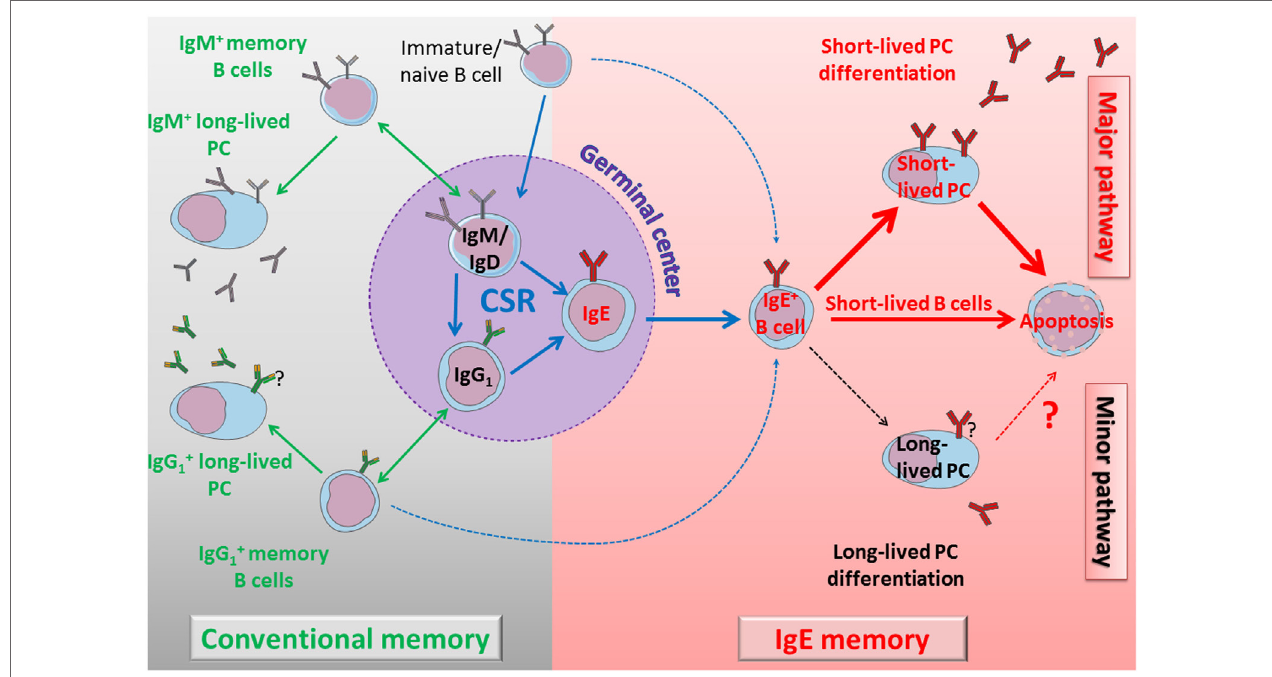
FigURe 4 | Self-controlled IgE production model. Left part: immature cells differentiate into naïve B cells and could undergo direct class switch recombination (CSR) to IgE or enter into the GC. During the GC reaction, cells can switch directly to IgG1 or IgE, or eventually undergo a sequential switching with an IgG1 intermediate and an extra-follicular CSR to IgE. IgM + and IgG1 + lymphocytes generate classical humoral memories, with memory B cells and long-lived plasma cells (PCs). These memory B cells can undergo more rounds of GC reaction to increase their antigen (Ag) affinity and to switch to IgG1 or IgE. Direct or sequential CSR produces membrane IgE + lymphocytes with different Ag affinity, and IgE B cell receptor (BCR) seems to induce a common, short-lived fate. Right part: IgE + lymphocytes have a bias in short-lived PC differentiation. These short-lived PCs strongly express IgE BCR and undergo massive apoptosis. Membrane IgE + lymphocytes are also counter-selected by various mechanisms including poor mobility, low membrane IgE expression, and spontaneous apoptosis. Long-lived PCs are very elusive but produce IgE antibodies for a long term, potentially including pathological IgE. A better characterization of these cells and their targeting to eliminate them could lead to new treatments to re-initialize IgE memory and deplete pathological IgE